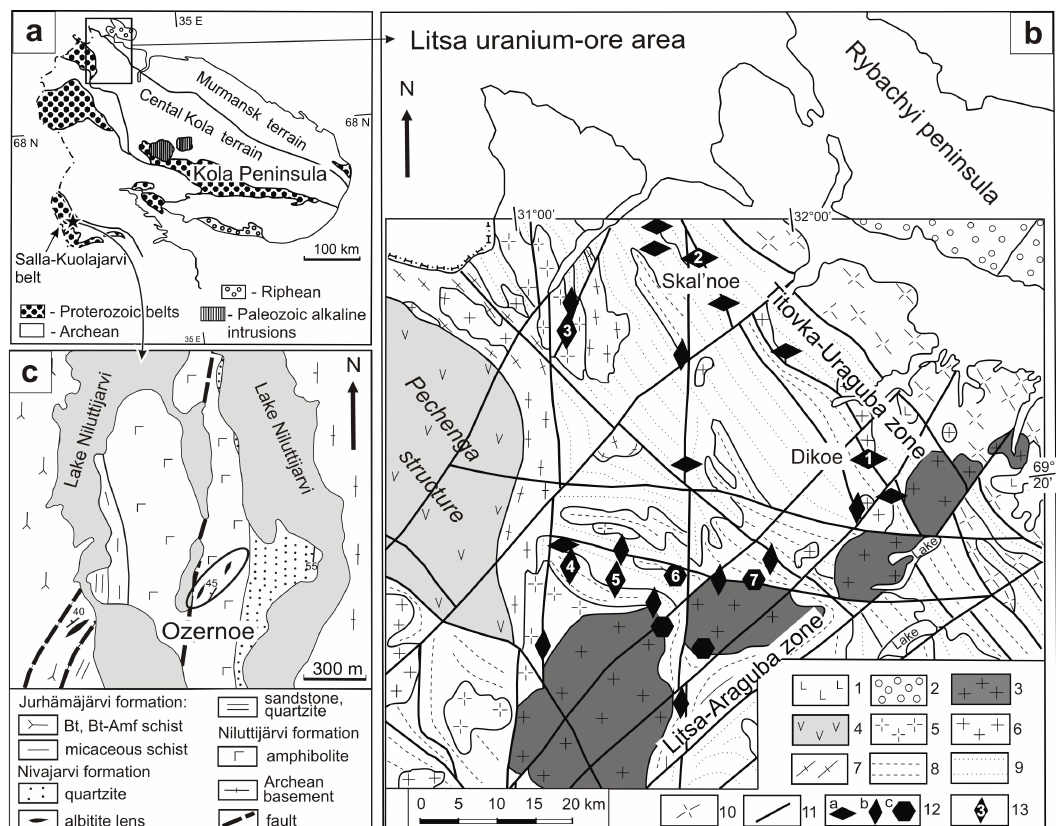
Figure 1. ( a ) Geological overview of the Kola region showing the locations of the Litsa area and the Salla belt; ( b ) Local geological map of the Litsa area (after [4]) with uranium occurrences. 1, 2—Riphean: 1—gabbro-dolerites and dolerites of the Murmansk complex, 2—sandstones, siltstones,